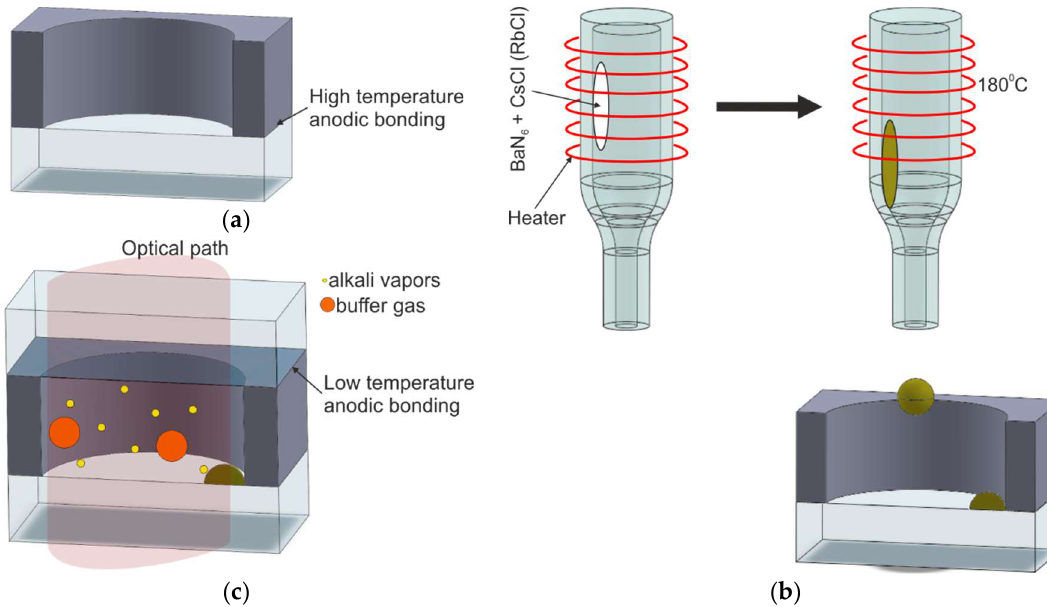
Figure 7. Introduction of cesium into the cell preform by pipetting of pure alkali metal: ( a ) silicon–glass preform, ( b ) drop insertion of liquid alkali metal, ( c ) cross section of the MEMS structure.